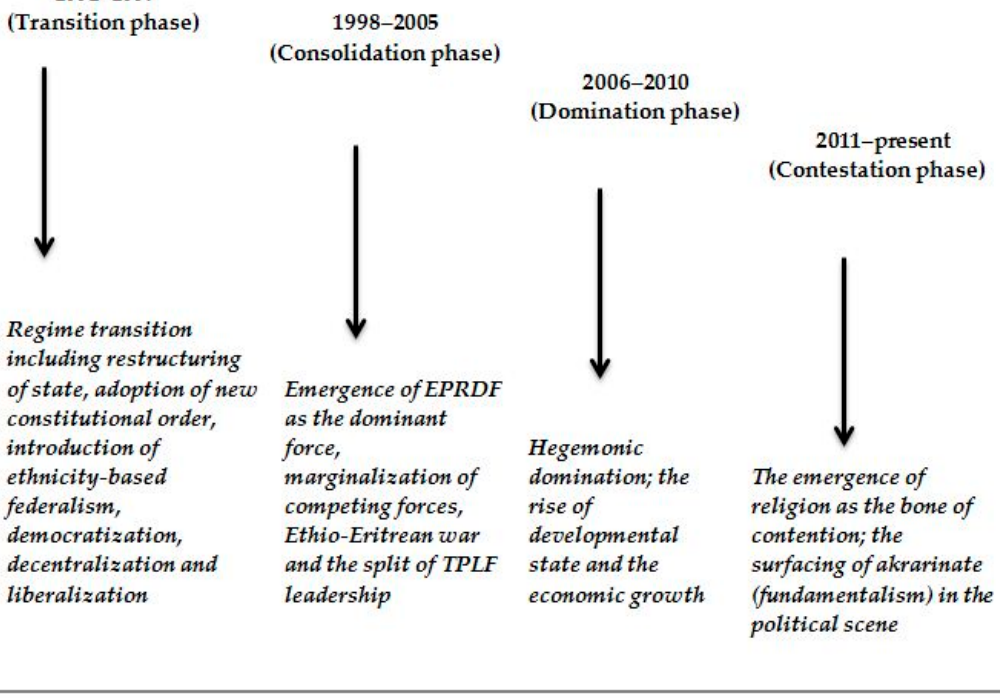
Figure 1. Post-1991 political dynamism in chronological order; source: developed by authors.